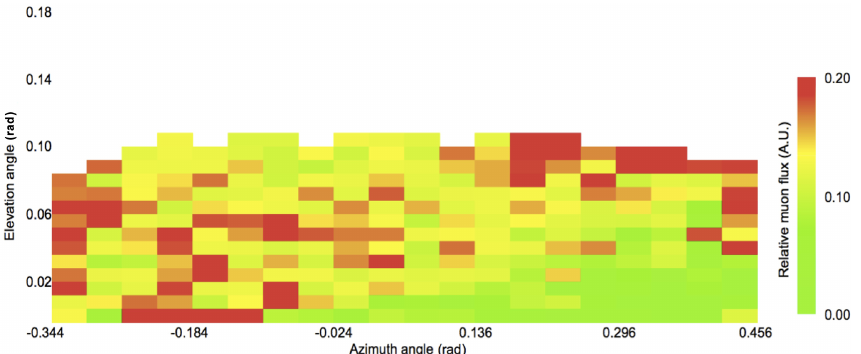
Figure 3. Angular distribution of the relative muon flux, as was observed from the measurement at Position A. The horizontal and vertical bin widths are respectively 40 and 8mrad. The azimuthal distribution of the relative muon flux was normalized to the total number of muons counted at each elevation angle.